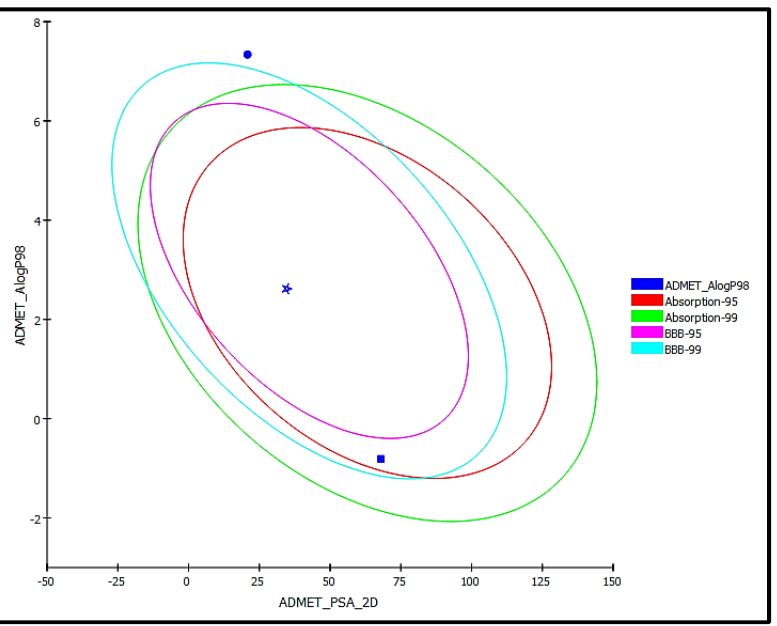
Figure 9. ADMET Plot for bioactive compound identified in n -hexane fraction of P. odorata leaves showing the 95% and 99% confidence limit ellipses corresponding to the blood-brain barrier (BBB) and the human intestinal absorption models; trans -phytol (filled circle); Co-crystalized ligand (Thio-lactomycin) (star); and isoniazid (filled square) in ADMET_AlogP98.